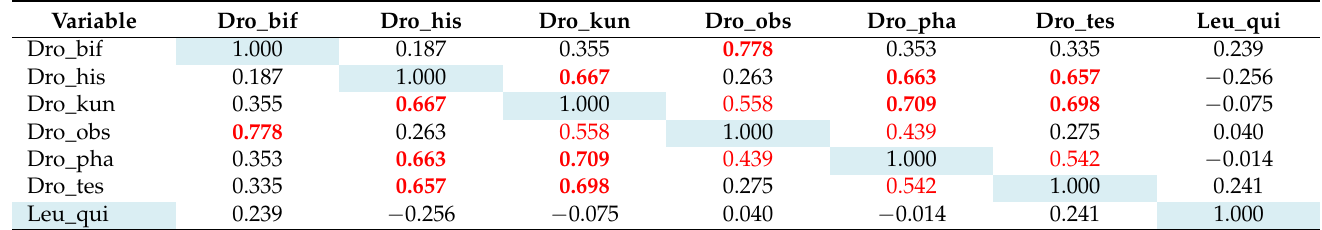
Table 2. Correlation of seasonal dynamics of the number of species D.obcura, D.bifasciata, D. histrio,